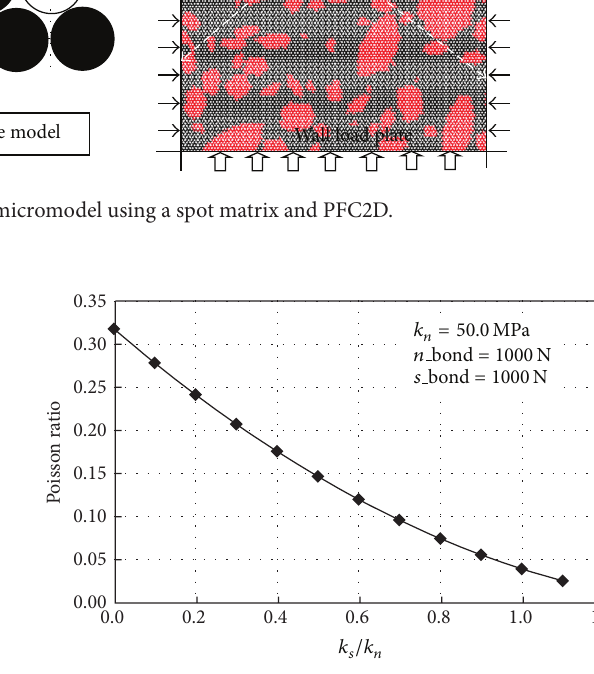
Figure 7: The relationship between Poisson’s ratio and the stiffness